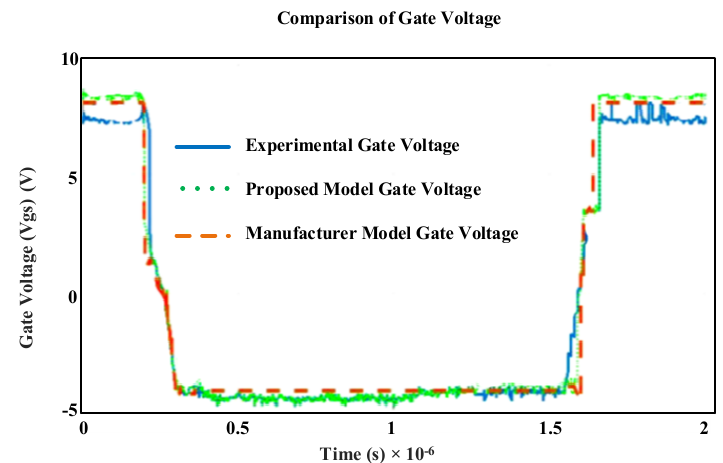
Figure 23. Comparison of gate voltage waveforms of models with DPT results.